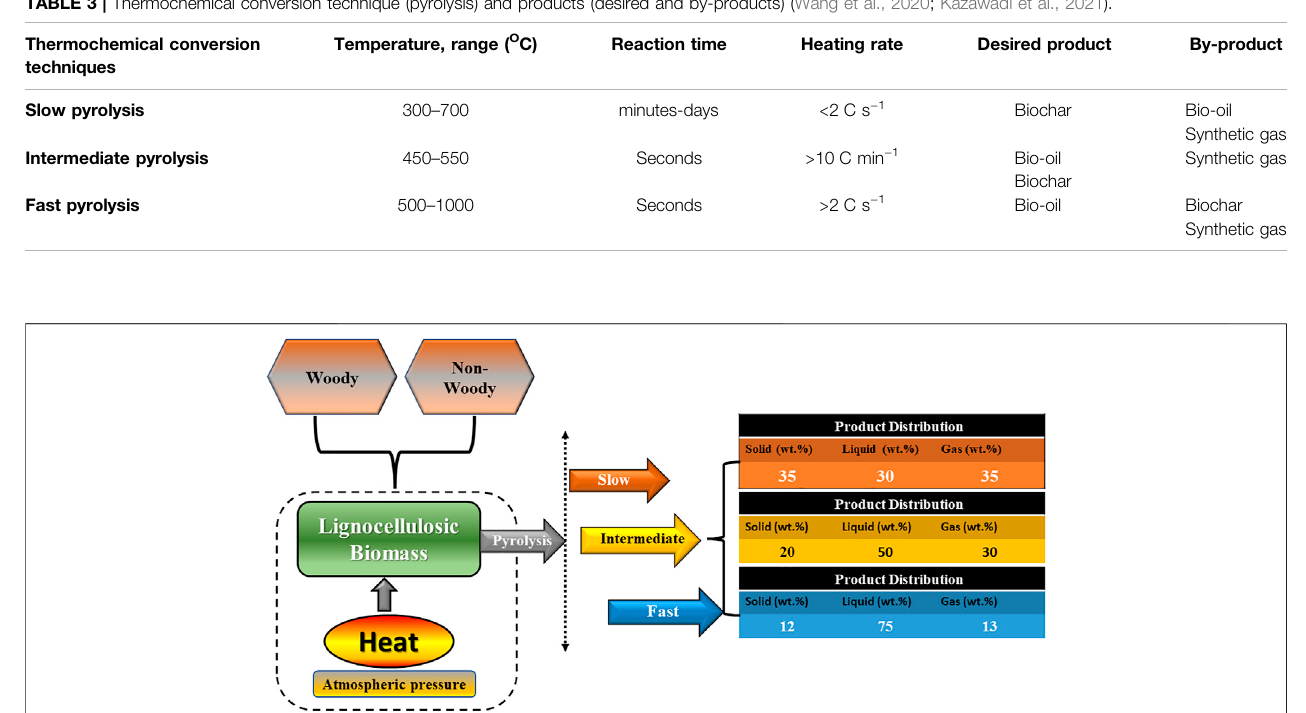
Frontiers in Materials |